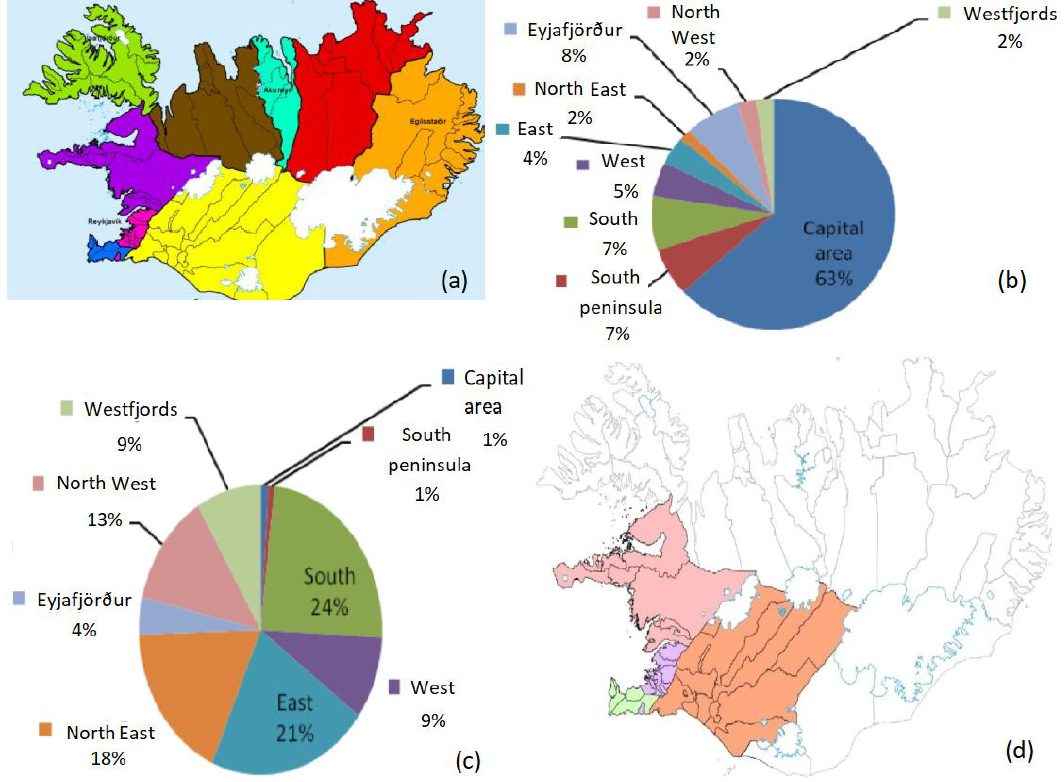
Figure 1. Map and information of Iceland, ( a ) all municipalities, ( b ) population share, ( c ) area share and ( d ) major region.